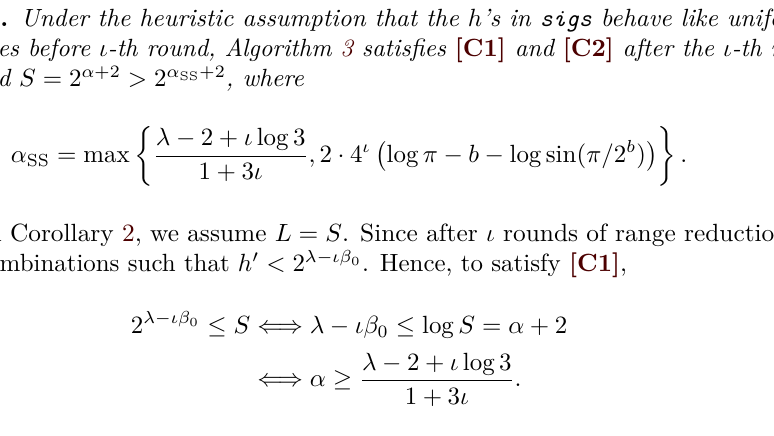
Algorithm 3 constructs linear combinations of four per each round, i.e., it